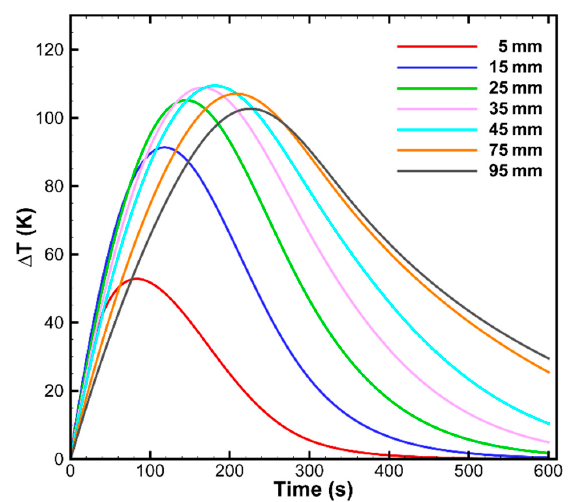
Figure 15. The profile of temperature in several axial positions over time.